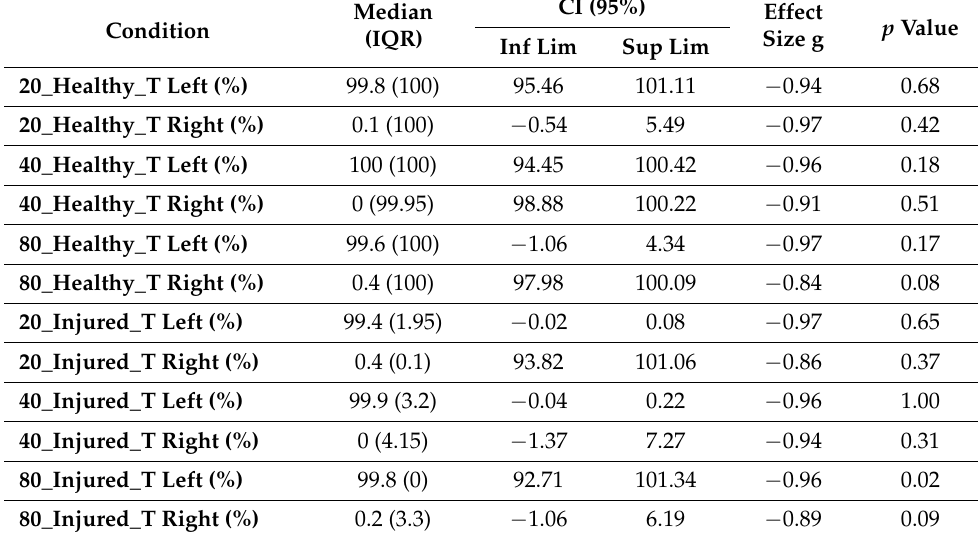
Interquartile Range (IQR). Coefficient Interval (CI) at 95%. Inferior Limit (Inf Lim). Superior Limit (Sup Lim). 20, 40, 80 describes the area of interesta at 20%, 40% and 80% of tendon length. Tendon (T). Effect Size g (Hedge’s g), statistical significance level p =